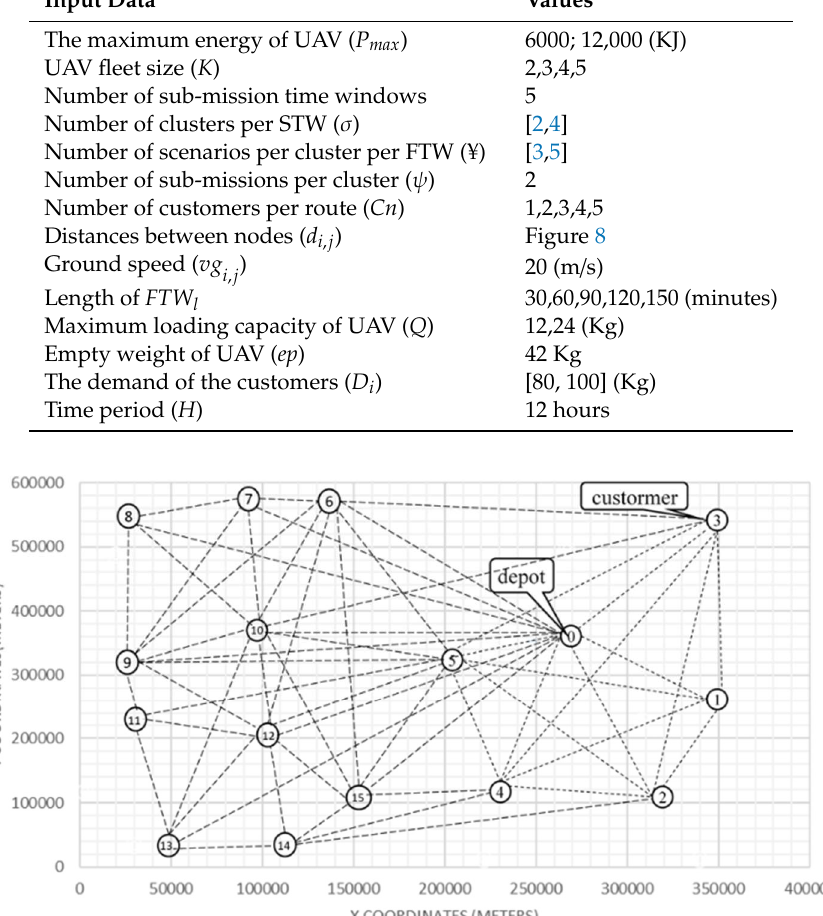
Figure 9. Scenarios assigned to UAVs, which have routes with common edge occupied at different times.